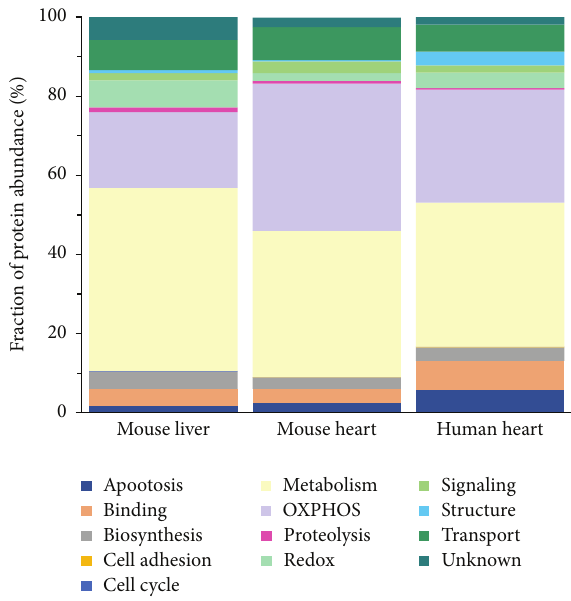
Figure 5: The analysis of functional clustering for mitochondrial proteins. Three mitochondrial proteins were involved including mouse heart mitochondrial dataset, mouse liver mitochondrial dataset, and human heart mitochondrial dataset. 𝑥 -axis represents different samples, 𝑦 -axis represents fraction of protein abundance, and the different colours represent different functional clusters. Functional annotations were distributed to 13 clusters due to biomedical properties of mitochondria. Metabolic proteins show highest abundance in mouse liver mitochondrial dataset, while oxidative phosphorylation proteins show highest abundance in cardiac mitochondrial